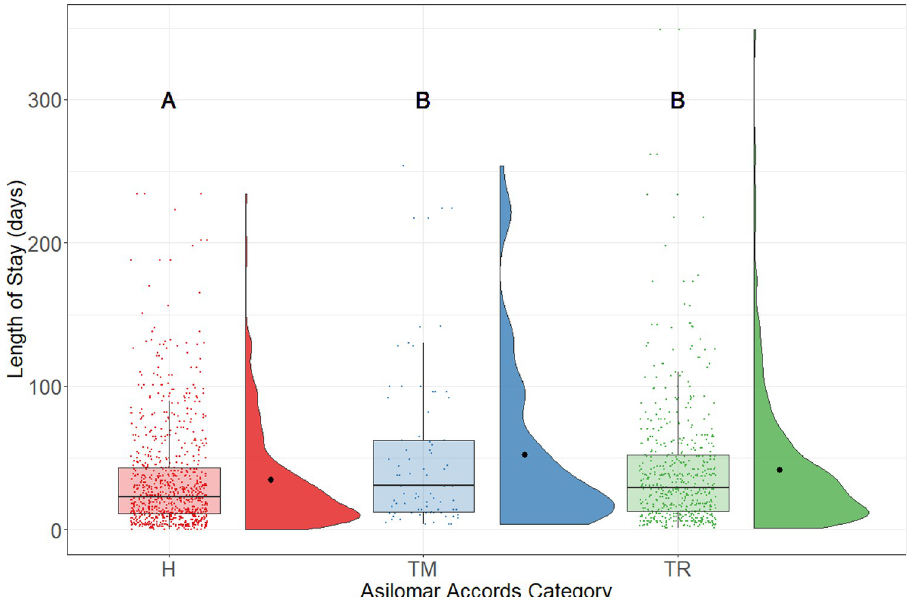
Fig 7. LOS of adopted rats by Asilomar accords category. Boxplots represent the median, the 25 and 75 percentiles, with whiskers representing the 95 percentiles. Individual data is shown by dots on the boxplot. Additionally, the rain cloud plots show the distribution and the means in each